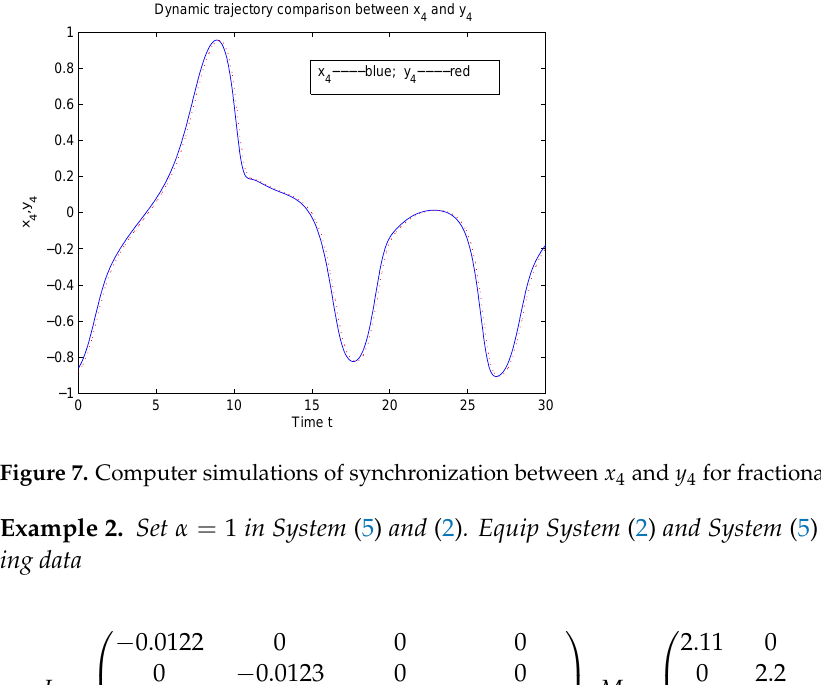
Figure 6. Computer simulations of synchronization between x 3 and y 3 for fractional-order 0.95.